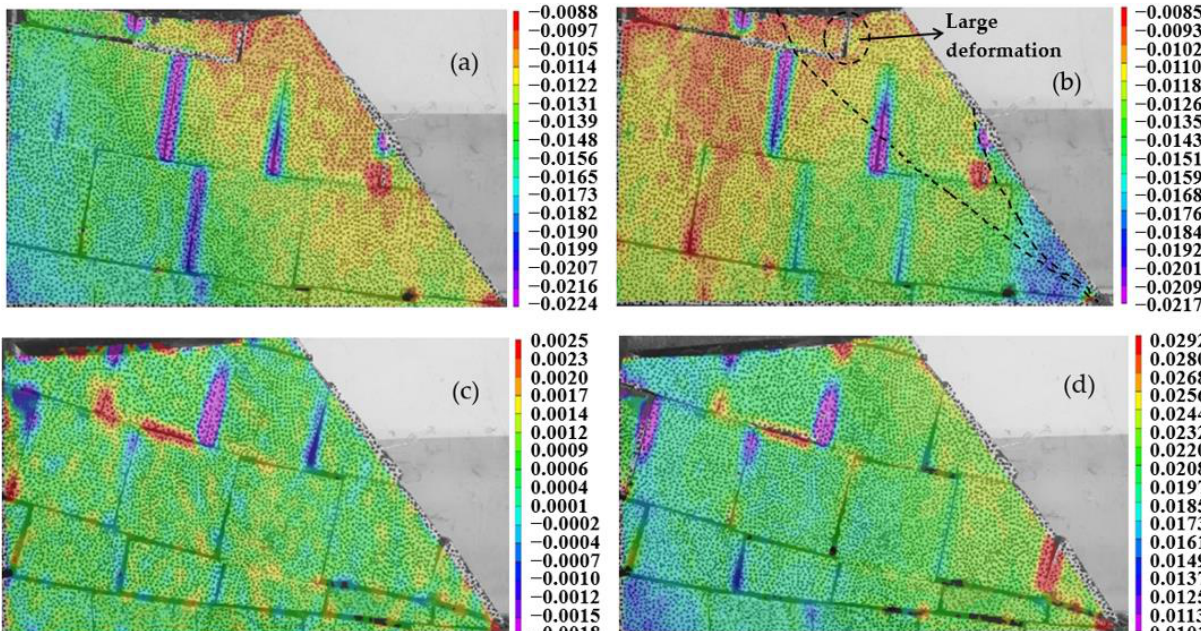
Figure 11. Strain contours of the slope model with horizontal crack networks under different loadings. ( a ) Under 1.6 MPa; ( b ) under 16 MPa.